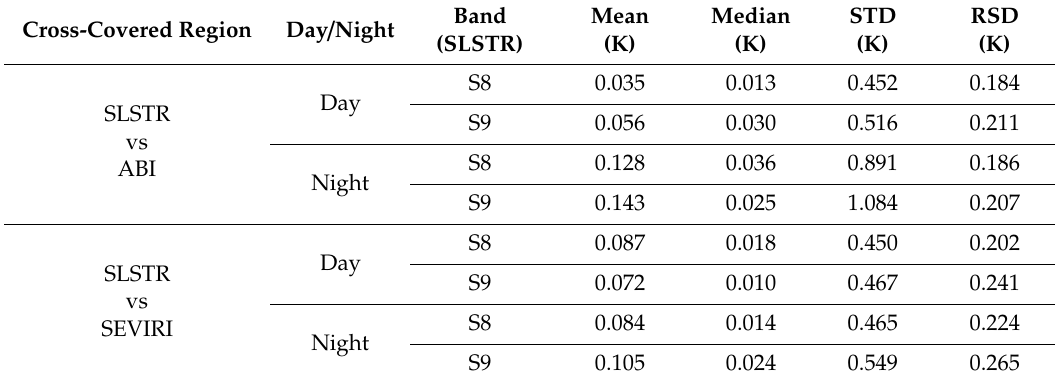
Table 6. Statistics of SLSTR BTs minus ABI / SEVIRI equivalent